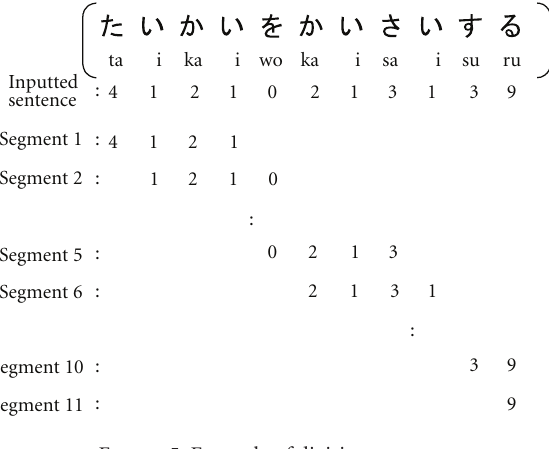
Figure 4: Procedure.